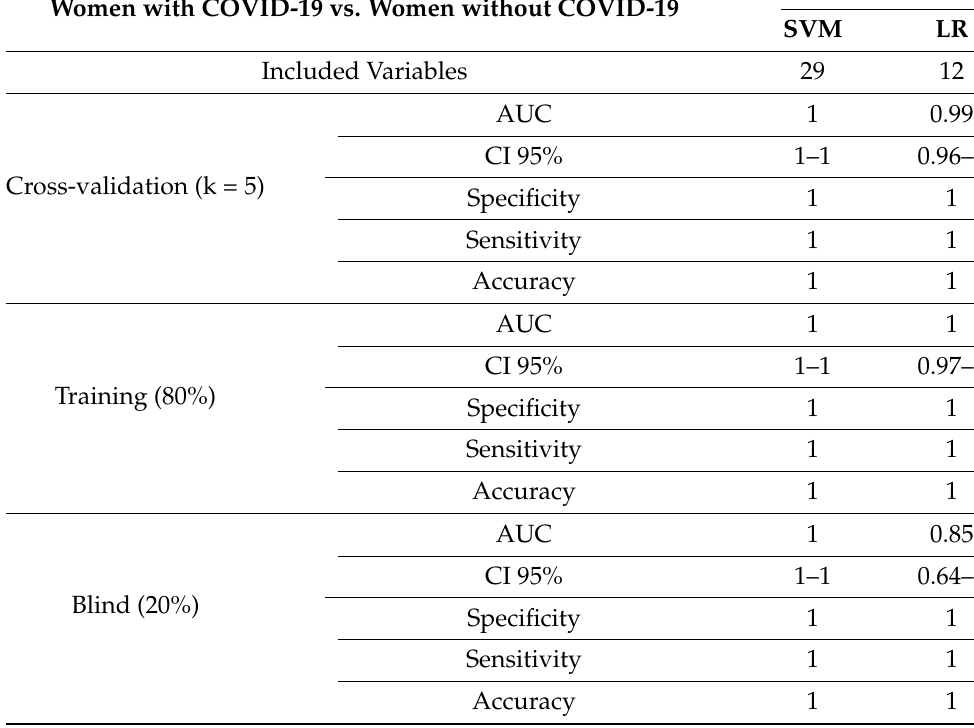
Table 3. Evaluation criteria for the logistic regression model with all factors and support vector machine for women with COVID-19 vs. women without